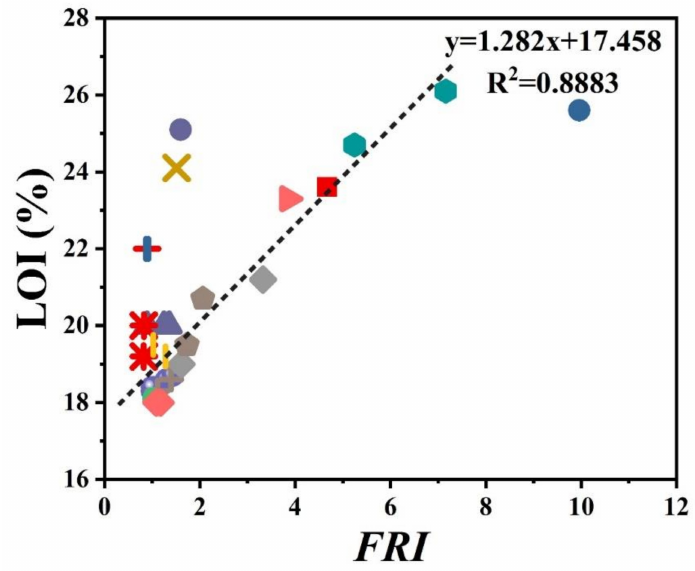
Figure 9. FRI values of PP as a function of LOI test results. Symbols are indicative of di ff erent types of mineral flame retardant